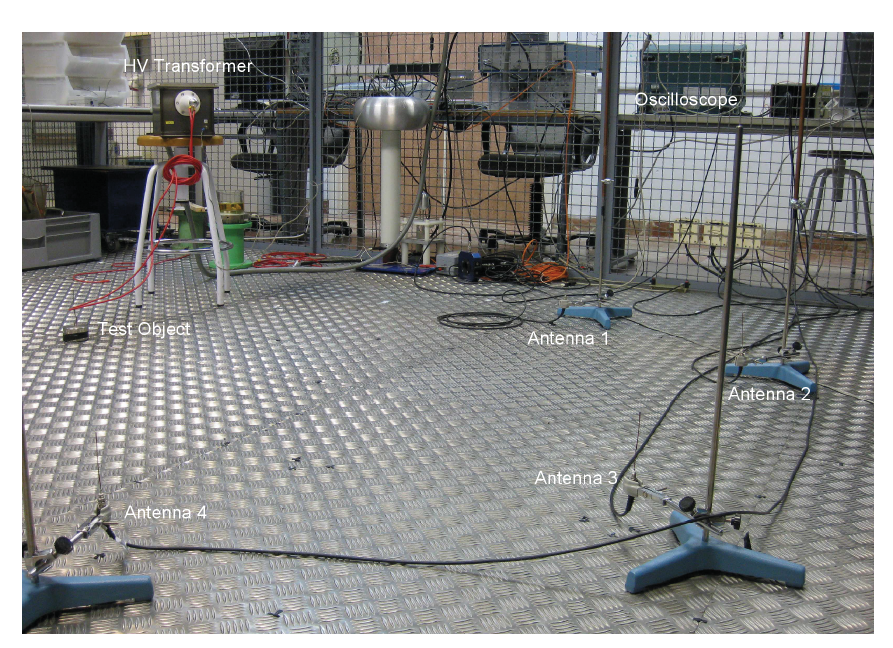
Figure 3. Antennal layout in the LINEALT high-voltage